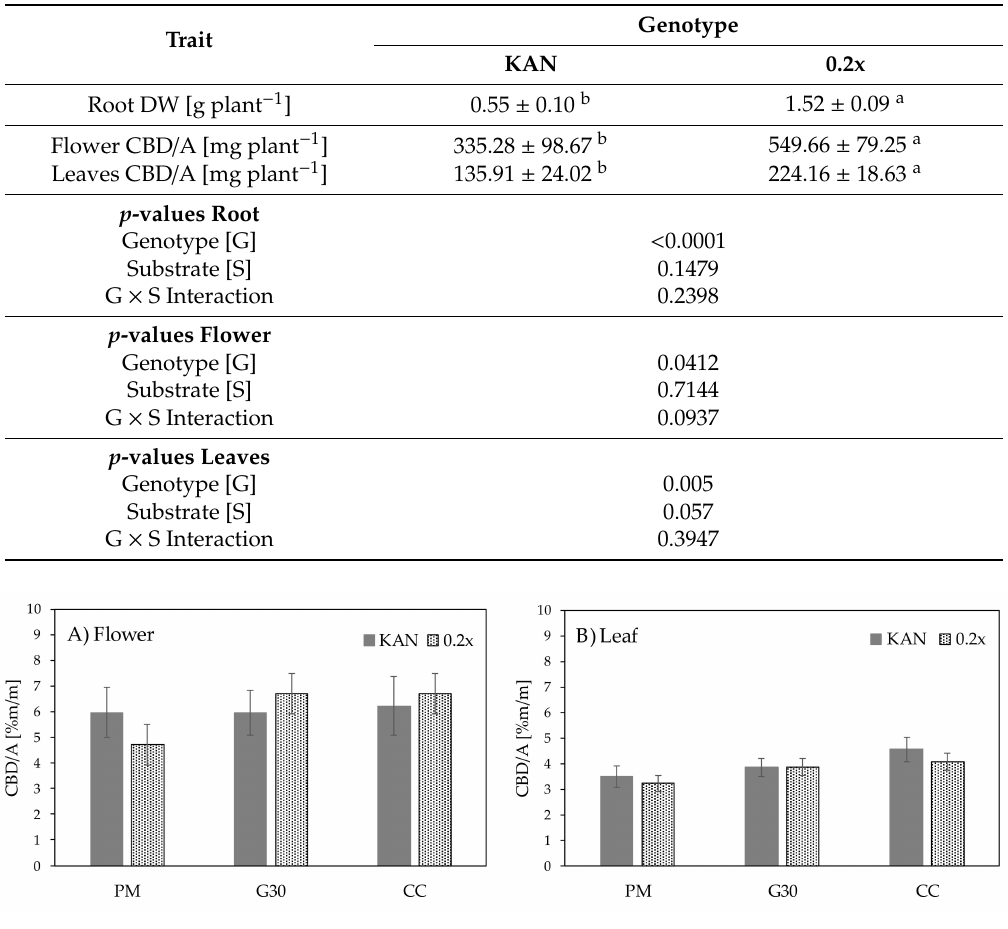
Figure 6. Mean content in ( A ) flower and ( B ) leaf of CBD / A in mass percent [% m / m ] of genotypes KAN and 0.2x treated with a peat-mix growth media (PM), peat-mix substituted with 30% green fibre (G30) and 100% coco coir fibre